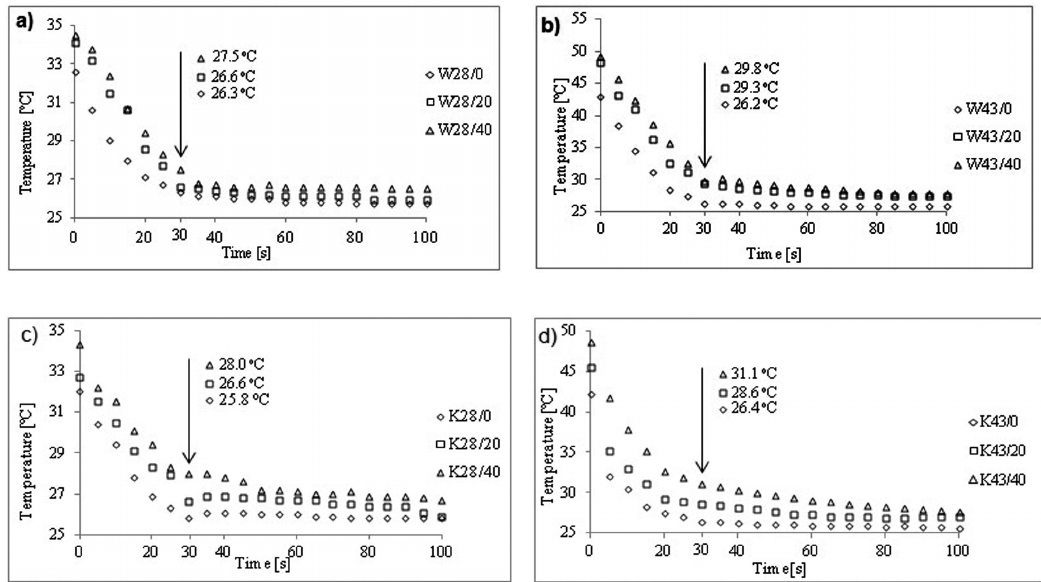
Figure 8. Temperature changes in the surface of materials during cooling process for: ( a ) woven fabrics W28 / 0, W28 / 20, W28 / 40; ( b ) woven fabrics W43 / 0 W43 / 20, W43 / 40, ( c ) knitted fabrics K28 / 0, K28 / 20, K28 / 40; ( d ) knitted fabricsK43 / 0, K43 / 20, K43 / 40.